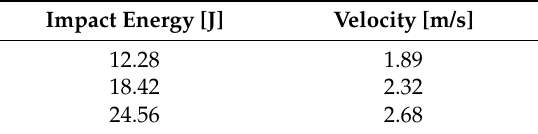
Table 2. Specification for low velocity impact tests.